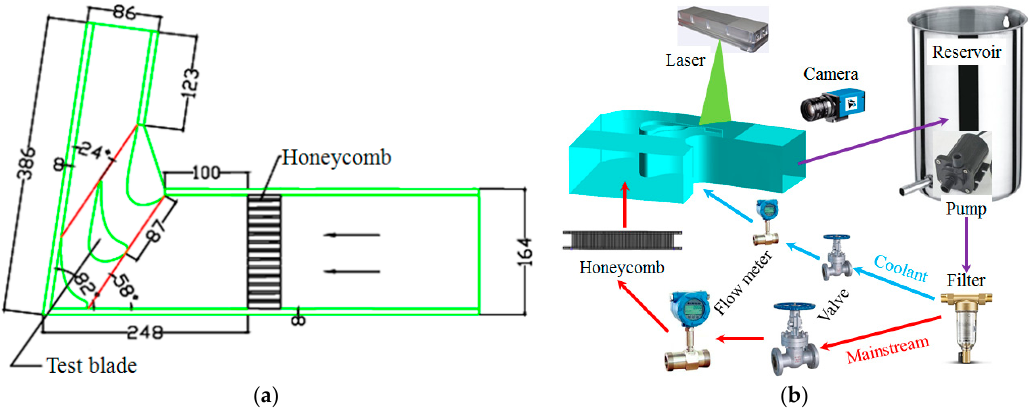
Figure 3. The schematic illustrations: ( a ) test section; ( b ) experimental apparatus.